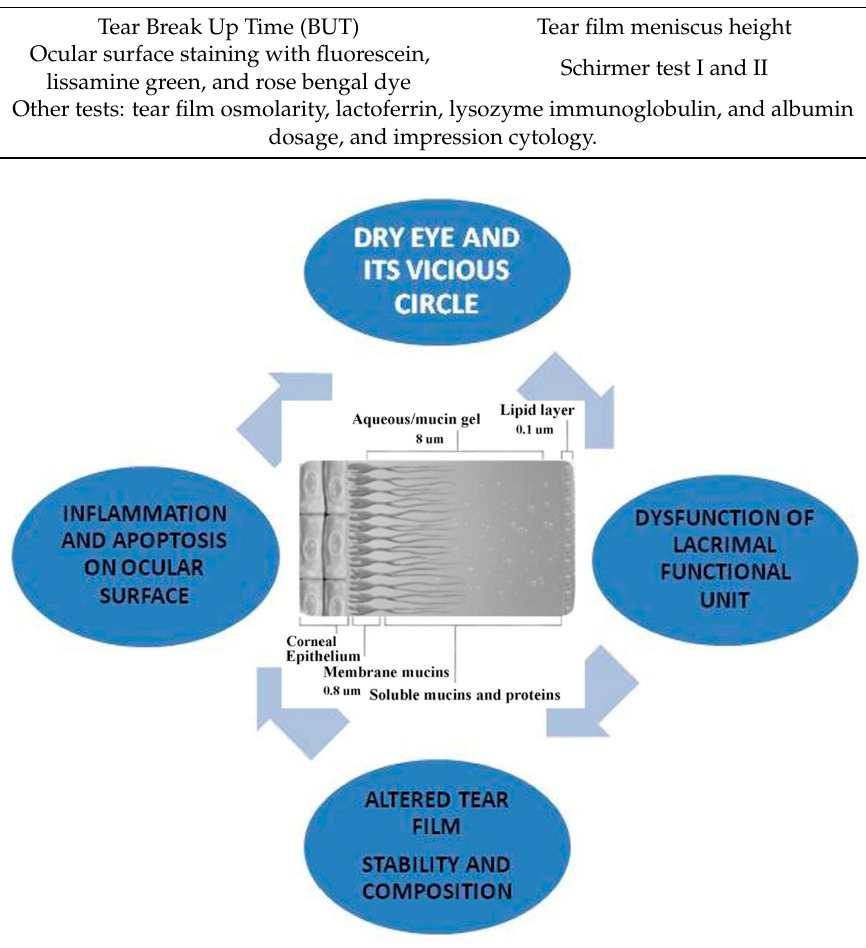
Figure 1. Dry eye and its vicious circle.